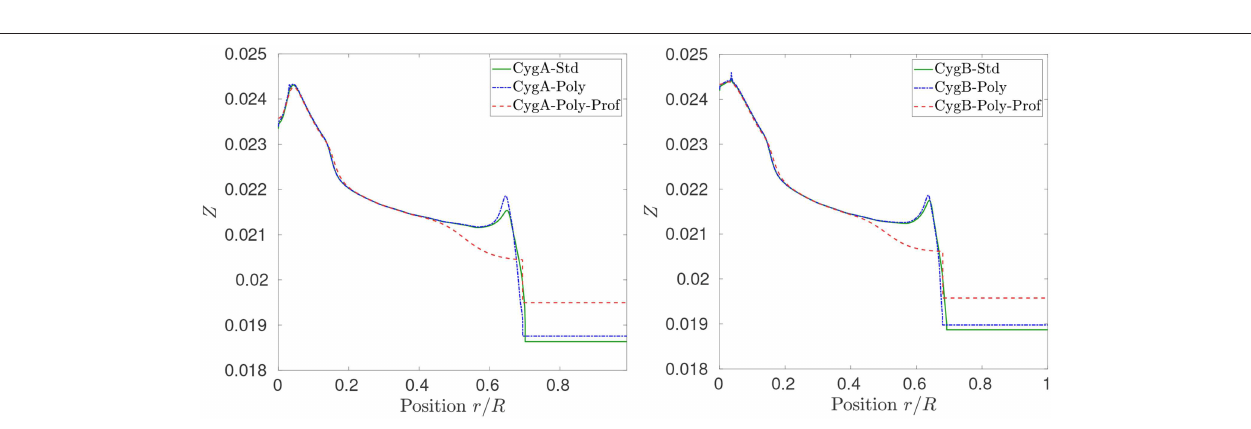
FIGURE 12 | Metallicity profiles as of function of r / R for the 16Cyg A and B models considered in this study. base of the convective envelope. Here, the higher opacity leads to a larger convective envelope, extending at higher